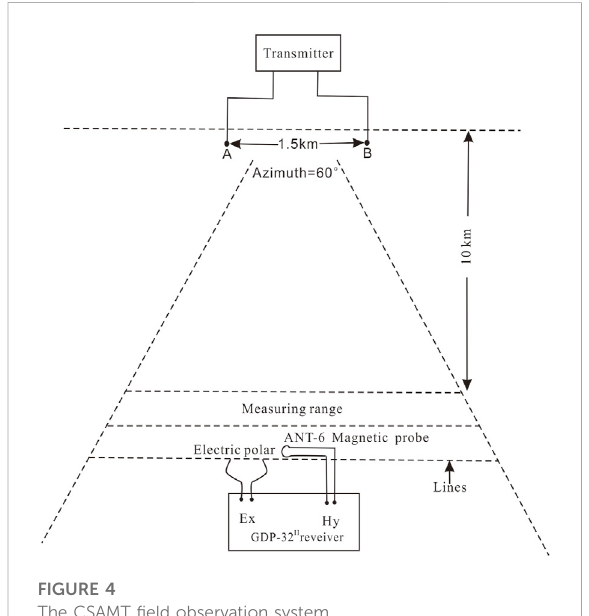
FIGURE 4 The CSAMT fi eld observation system.